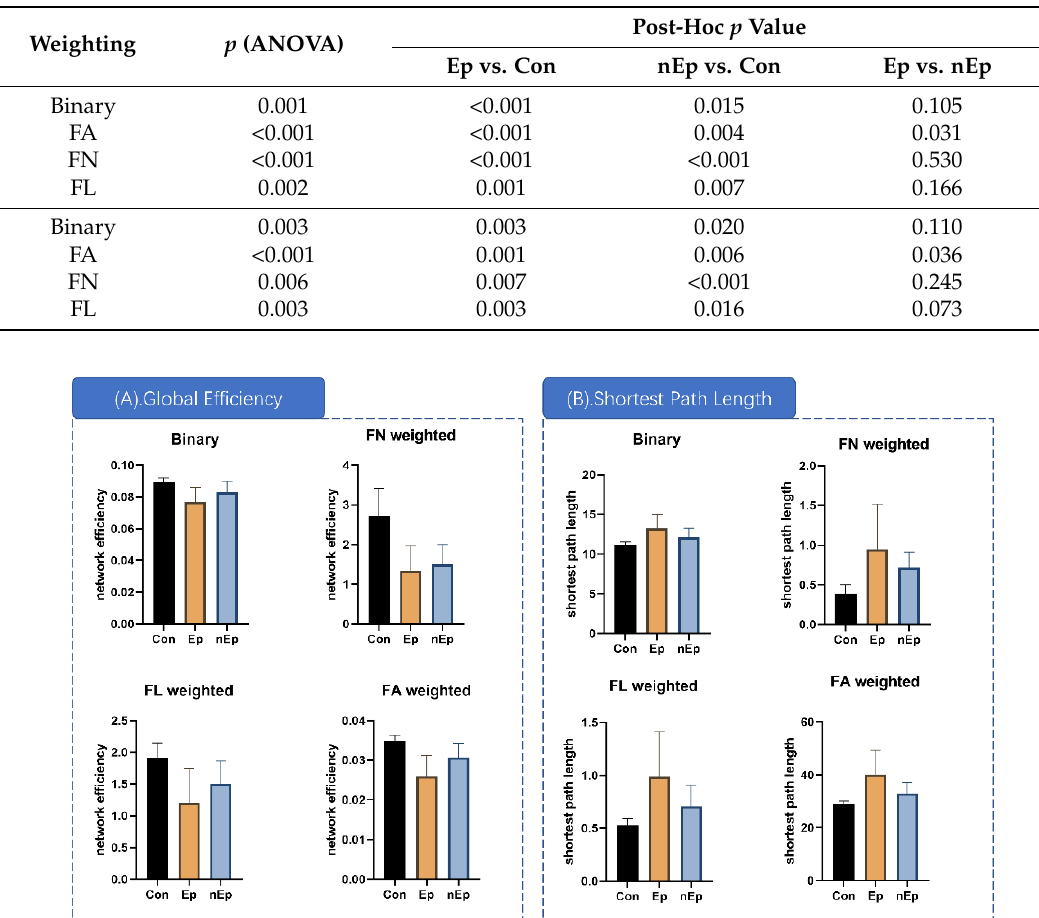
Figure 4. Global properties differences. ( A ) The global efficiency of Ep group markedly decreased than control in binary, FA, FN, and FL. The global efficiency og nEp group is also significant decreased than control in the above four weightings. Ep group only showed lower global efficiency in FA weighting comparing to nEp. ( B ) The shortest path lengths of Ep group showed noticeable increase than the control group in the above four weightings. Likewise, the shortest path length of nEp group is also significantly higher than control. Ep group only showed increase of shortest path length in FA weighting comparing to the nEp.